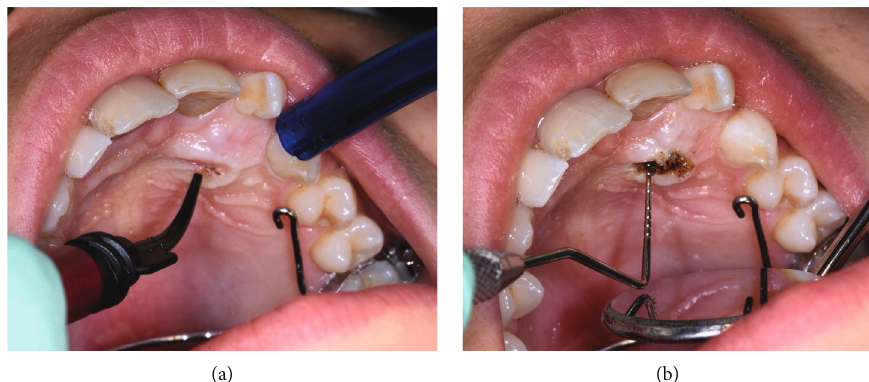
Figure 3: (a and b) Intraoral photo during surgical procedure.